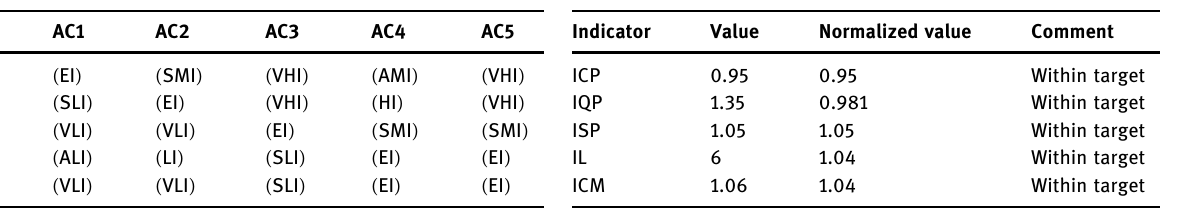
Table 11: Contractor 1 normalized calculations for